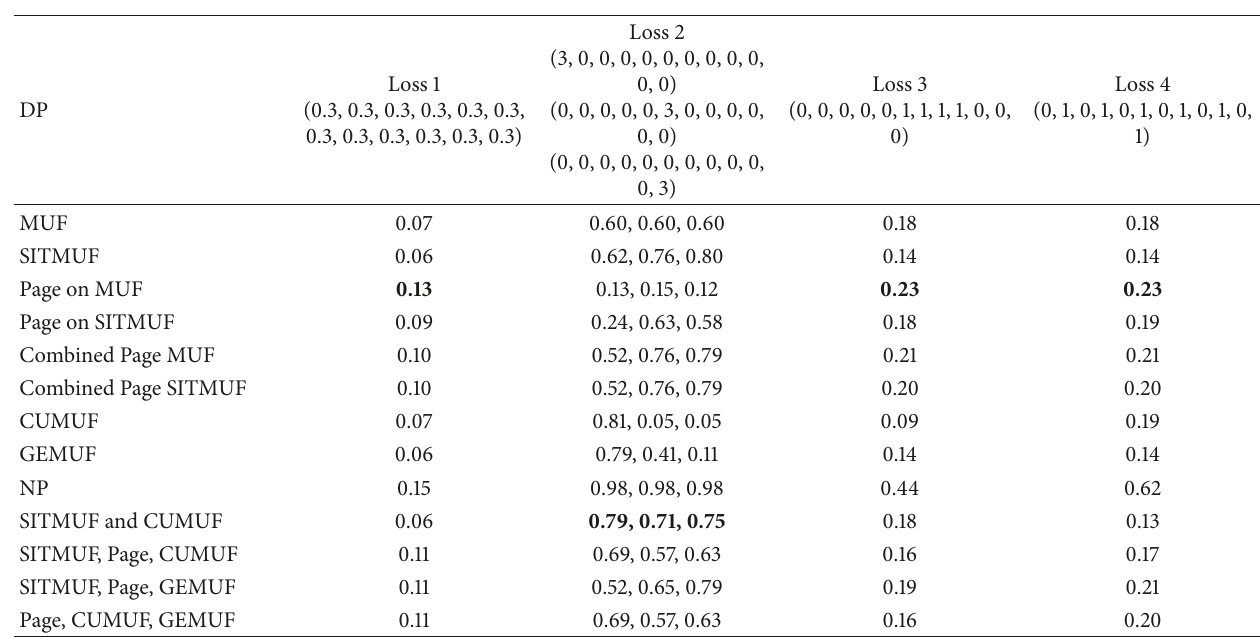
Table 2: DPs for Σ 2